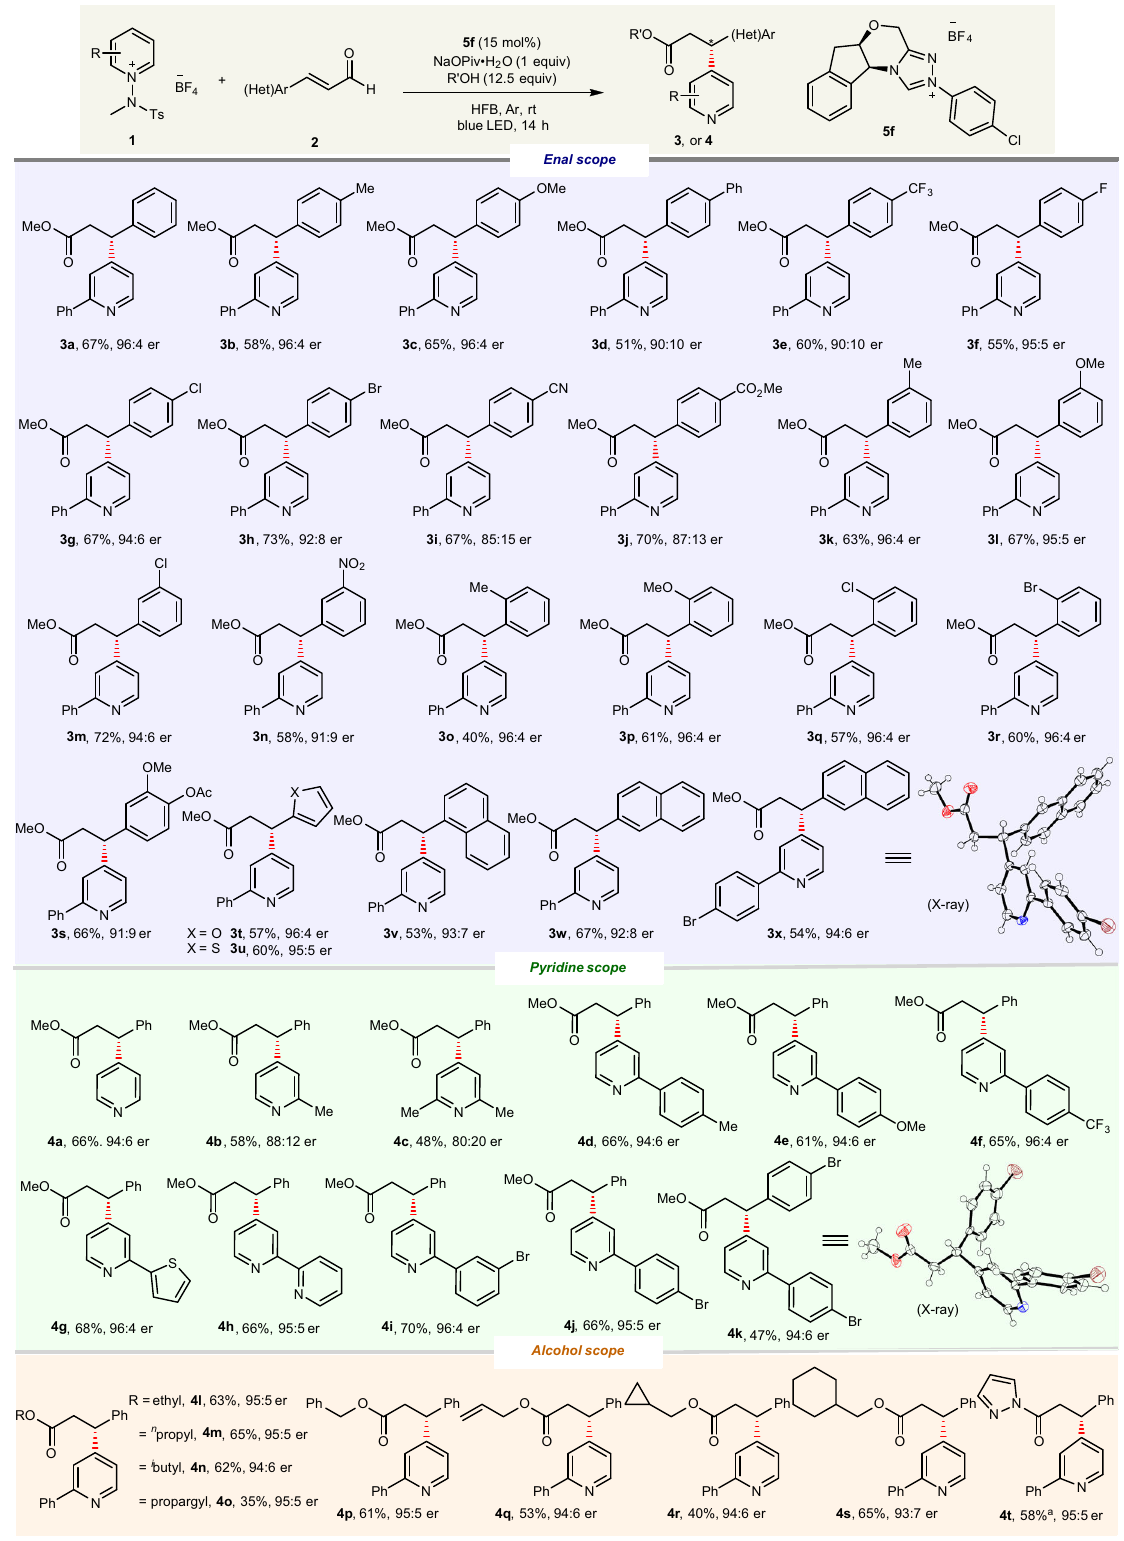
Fig. 2 Substrate scope. Reaction conditions: 1 (0.05 mmol), 2 (2.0 equiv), NaOPiv (cid:129) H 2 O (1.0 equiv), and 5f (15 mol%) in HFB (2.0 mL) under light irradiation using blue LEDs (440 nm, 10 W) at rt under Ar for 14 h. a Pyrazole (2 equiv) was